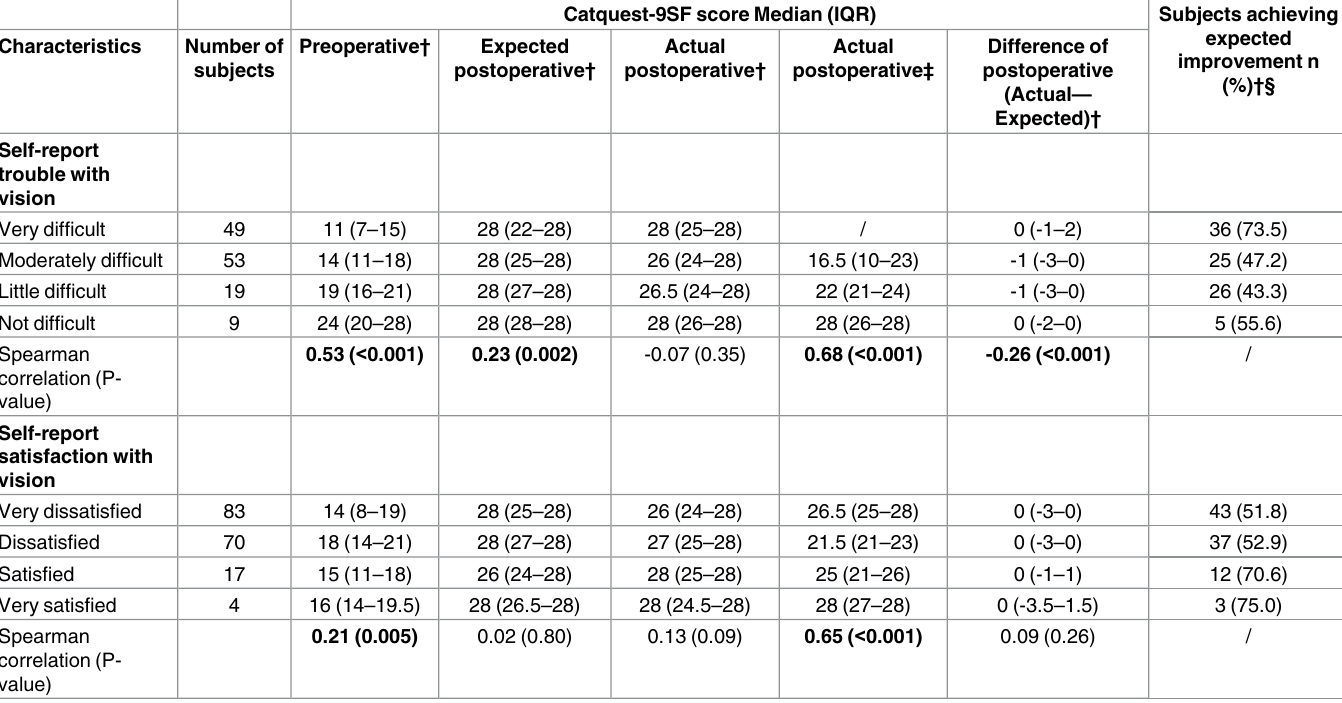
Table 4. Preoperative difficulty, expected and actual postoperative improvementon the Catquest-9SF itemsby functional characteristics (N = 174) * .